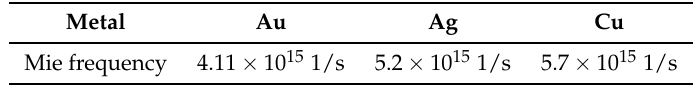
Table 2. Mie frequency ω 1 to Formula (17).